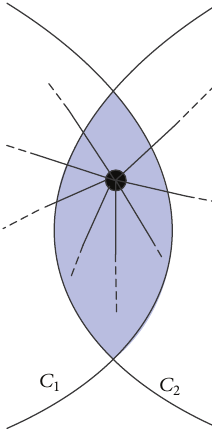
Figure 2: The common overlap.